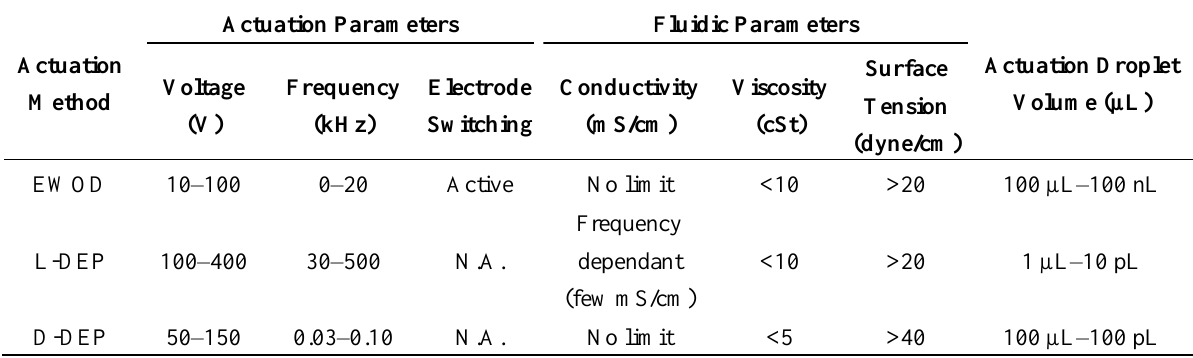
Table 1. Actuation parameters and the range of fluidic parameters for different droplet electro-actuation